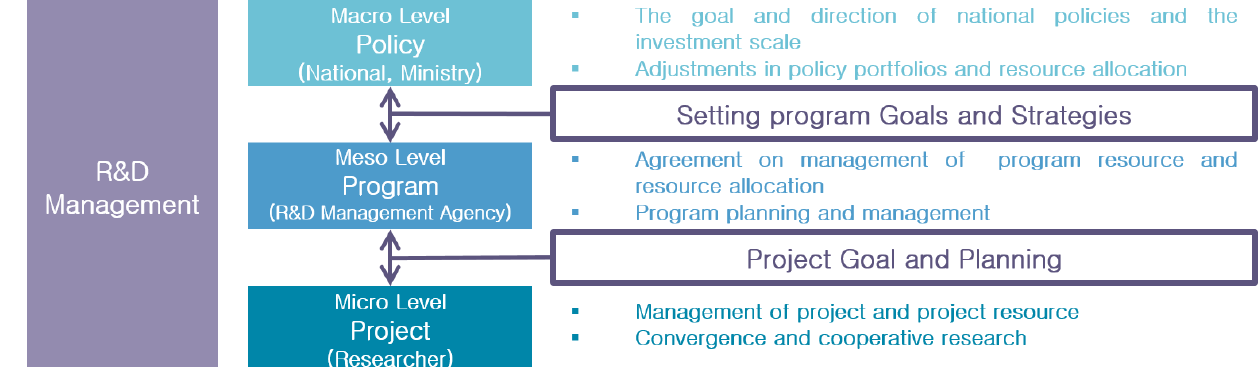
Table 1. Current status of R&D management agencies (2020).